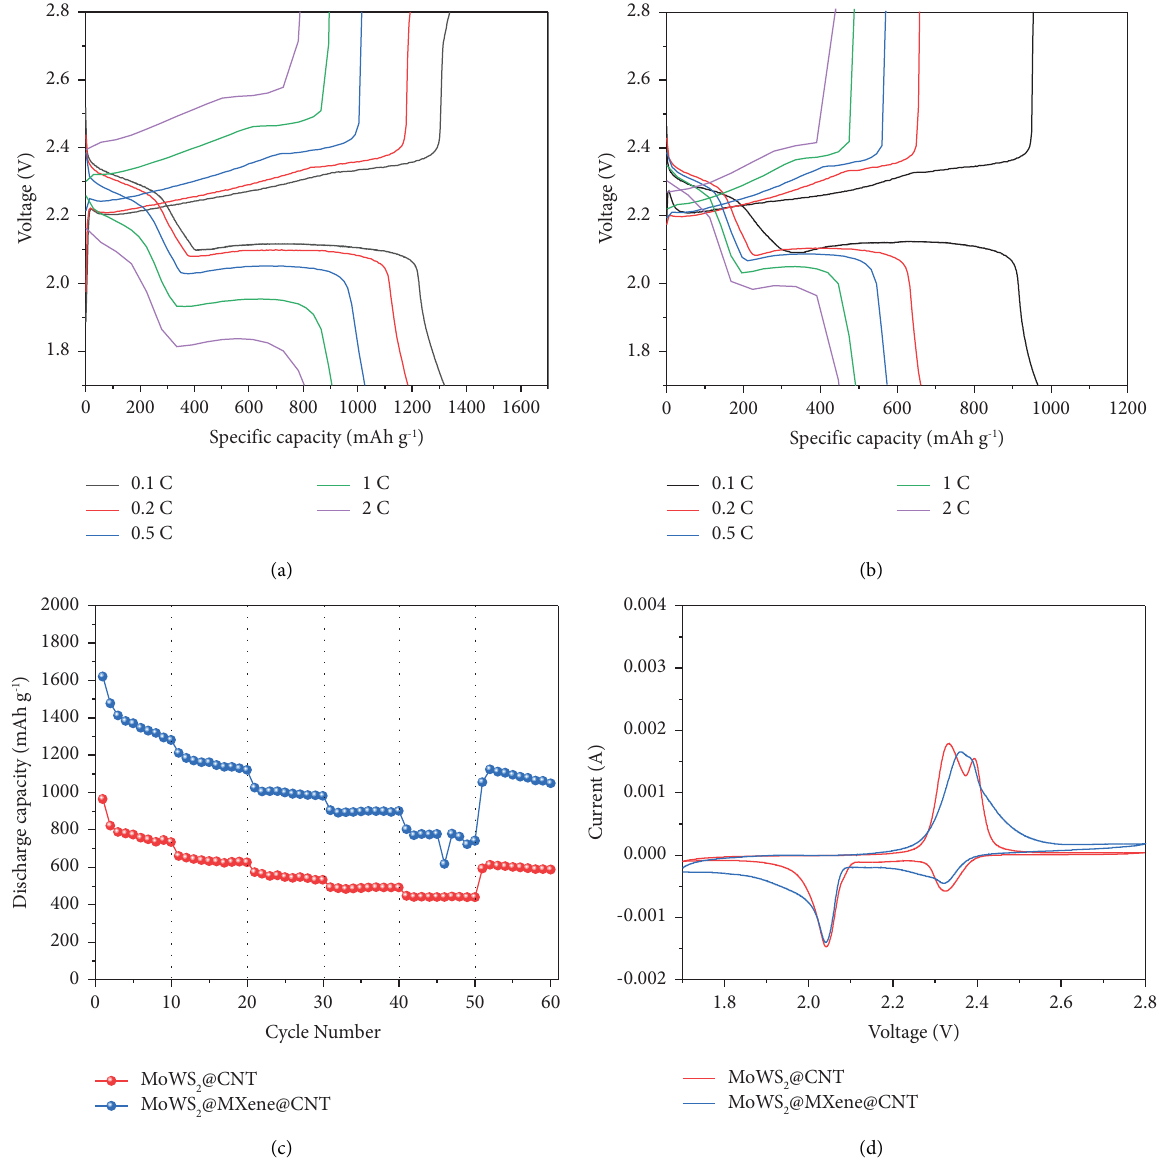
Figure 7: (a) and (b) First charge/discharge profles of the MoWS 2 @MXene@CNT/S and the MoWS 2 @CNT/S, (c) rate curves of the MoWS 2 @MXene@CNT/S and MoWS 2 @CNT/S, and (d) C-V curves of the MoWS 2 @MXene@CNT/S and the MoWS 2